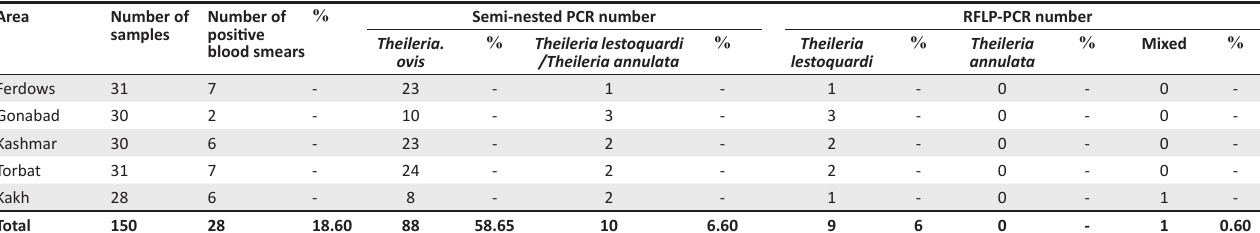
TABLE 3: Molecular and microscopic detection of Theileria species in blood samples of sheep in the south of the Khorasan Razavi province. Area Number of samples